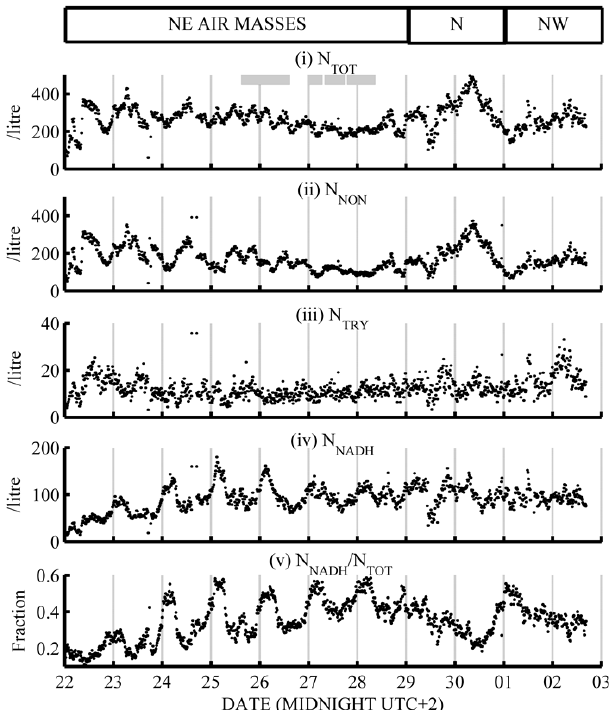
Fig. 1. ( i to iv ) WIBS-3 number concentrations of fluorescent and non-fluorescent particle types (v) number fraction of N NADH and relative humidity time series from 22 June to 3 July 2010. Grey boxes denote when ELPI samples were running and white boxes show modelled air mass